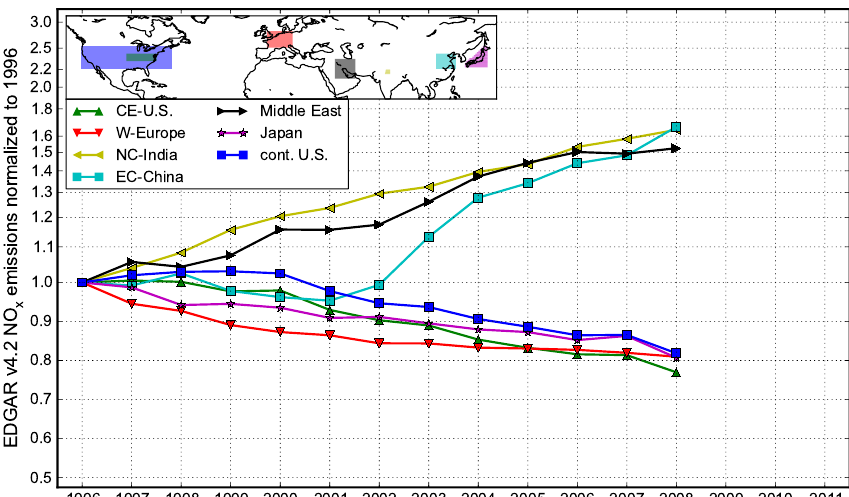
Fig. 3. NO x emissions from the EDGAR v4.2 database, normalized to 1996, for the regions central East Coast US, Western Europe, US, east-central China, Japan, Middle East, and north-central India. The y-axis has been modified to make relative changes above and below 1 more comparable (values larger than 1 have been scaled to y 7→ 2 − 1 ). Since the published version 4.2 of the EDGAR database contains erroneous emission data for the year 2008 in Iran, this plot uses an updated, so far unpublished, version (G. Maenhout, personal communication, 2012) for the Middle East region.